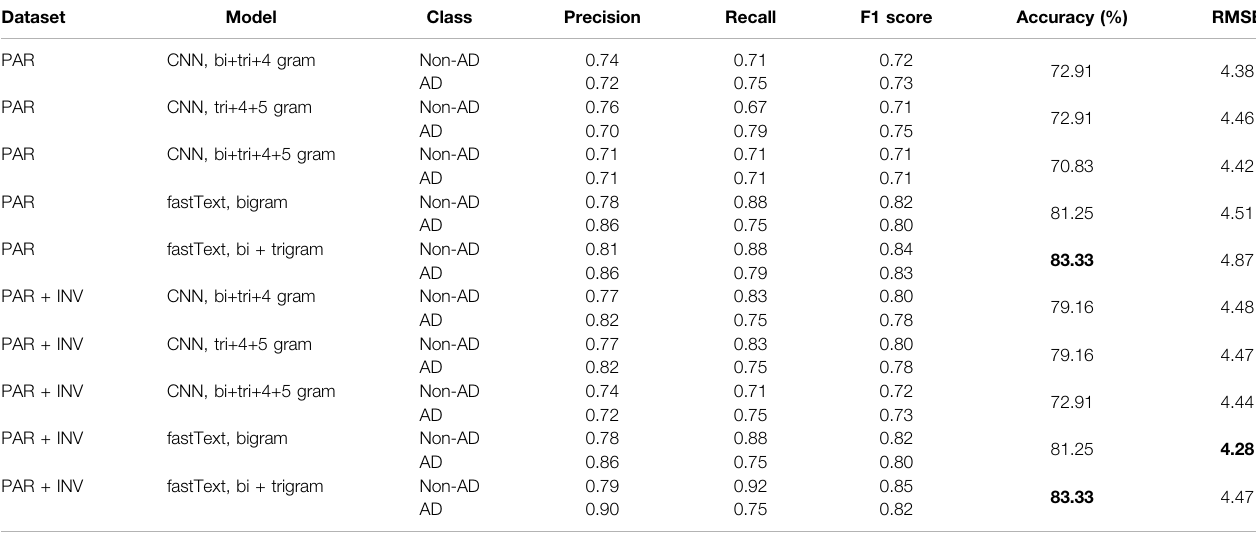
TABLE 3 | Results on ADReSS test set. The bold values represent the best results obtained by our models. Dataset Model